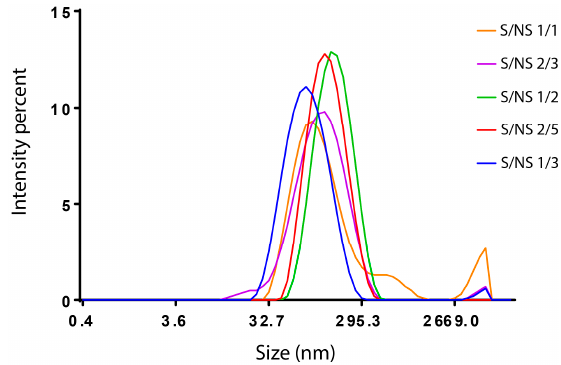
Figure 6. BSA particle size distribution obtained by Malvern Zetasizer. BSA 2%, at room temperature, and pH between 6.8 and 7. At different solvent/non-solvent volume ratios: S/NS 1/3; S/NS 2/5; S/NS 1/2; S/NS 2/3; S/NS 1/1.